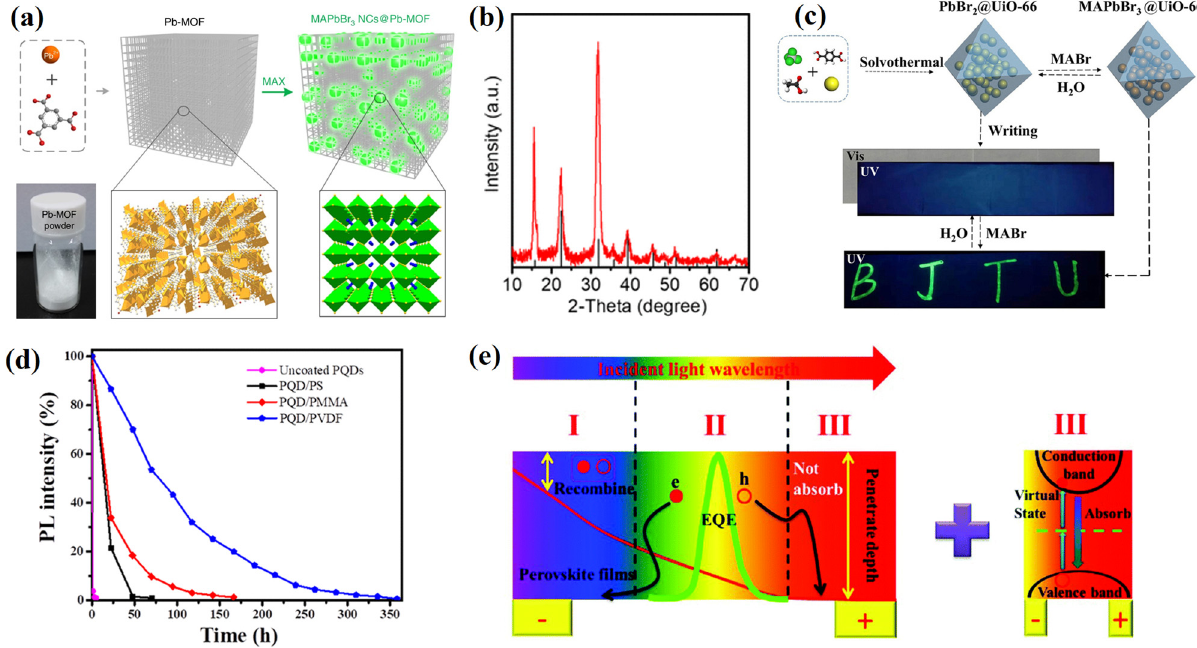
Figure 9: ( a ) Schematic diagram of the conversion of lead - based MOF powder to CH 3 NH 3 PbBr 3 ( MAPbBr 3 ) NCs, reproduced with